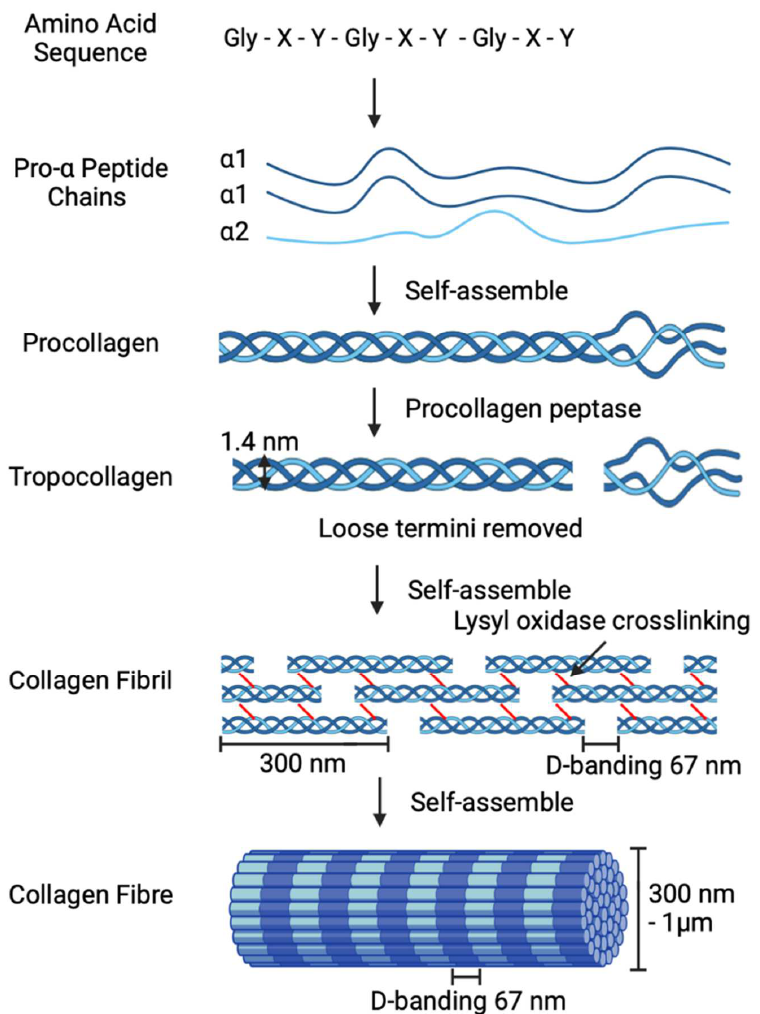
Figure 1. Schematic of collagen type I synthesis including amino acid sequence, pro- α peptide chains, procollagen, tropocollagen, collagen fibril, and fibre.